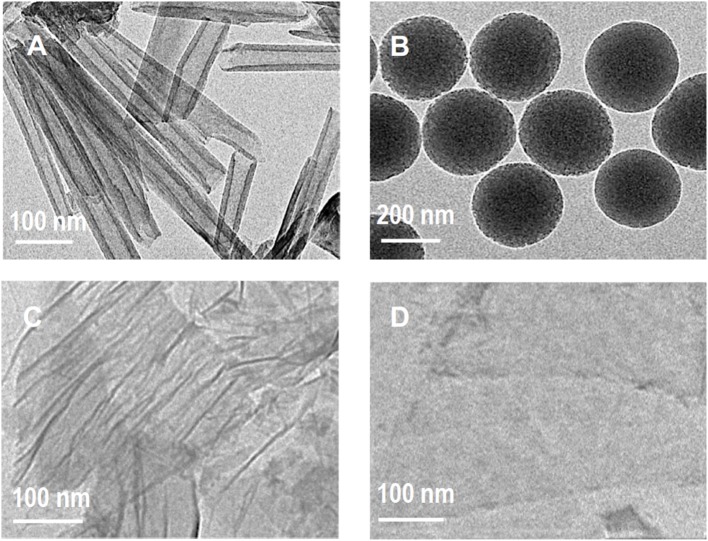
TEM images of (A) m-HNTs, (B) SiO2, (C) GO, and (D) MXene.